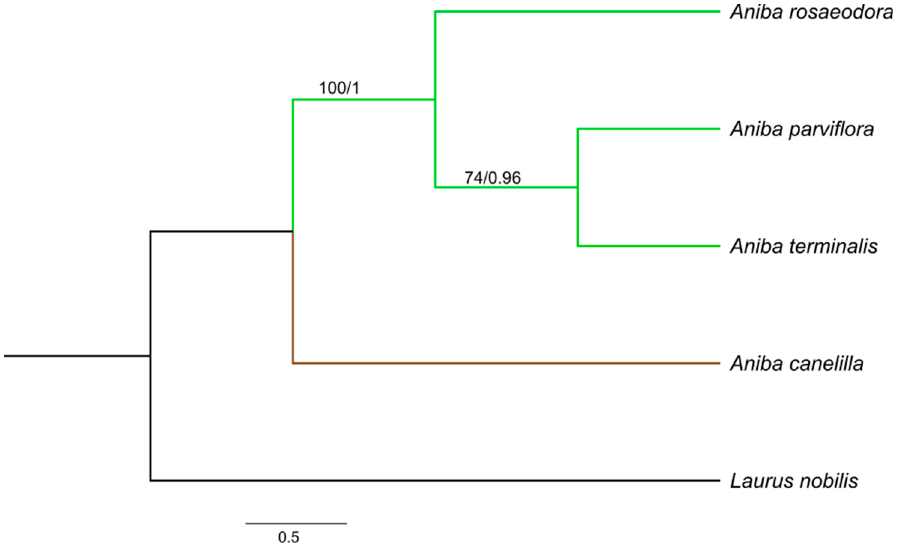
Figure 4. Bayesian consensus tree based on rbcL+matK+ ITS sequences of species of Aniba and Laurus nobilis (outgroup). Bootstrap support values ( ≥ 74%)/Bayesian posterior probabilities (>0.9) are shown above the branches.